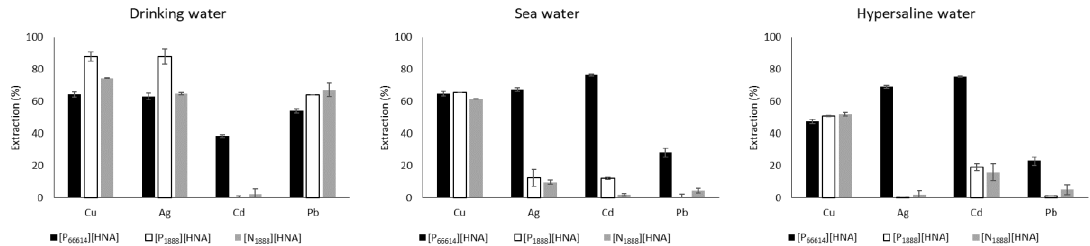
Figure 4. Extraction efficacies of the SBME setups using pure [P 66614 ][HNA] and the two respective 50 wt% dodecan-1-ol mixtures of [P 1888 ][HNA] and [N 1888 ][HNA] in natural water feed solutions for an extraction time of 2 h (n = 3, error bars = ±